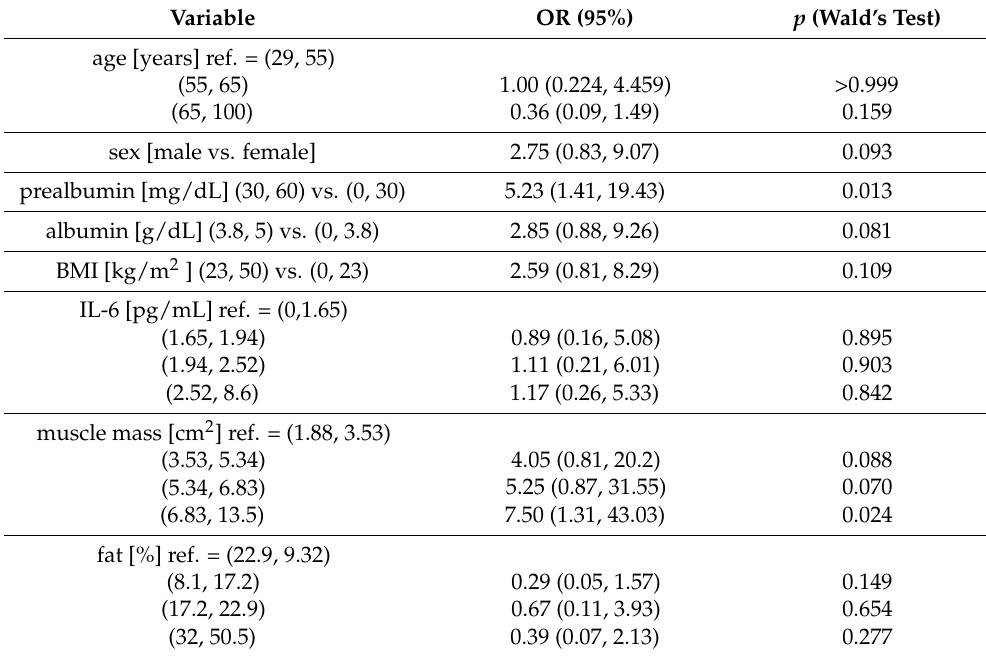
Table 5. Results of a crude analysis: odds ratio for survival. Variable OR